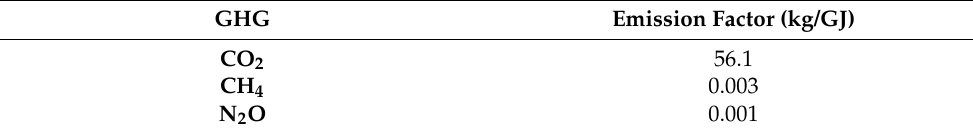
Table 17. The emission factors of natural gas [50].